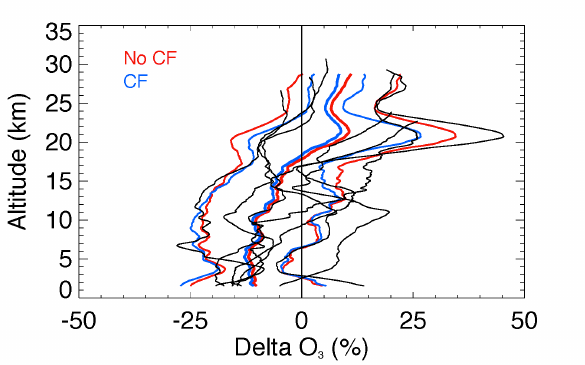
Figure 8. A comparison of the mean (thick) and mean ± 1 σ percent differences between the En-Sci ECC sondes launched from Hokkaido University and the CI sondes from the Sapporo station ((CI – ECC) / ECC), both with (blue) and without (red) the CFs applied for the 7 launches that occurred on the same days. Only the ECC sondes reaching least 29 km altitude before bursting (20040210, 20040526, 20050125, 20060906, 20080729, 20090812, and 20090818) are shown. The percent differences for the individual flights appear as the black lines. A 3-km boxcar smoothing function is applied to the percent difference data due to the limited number of coincidences.